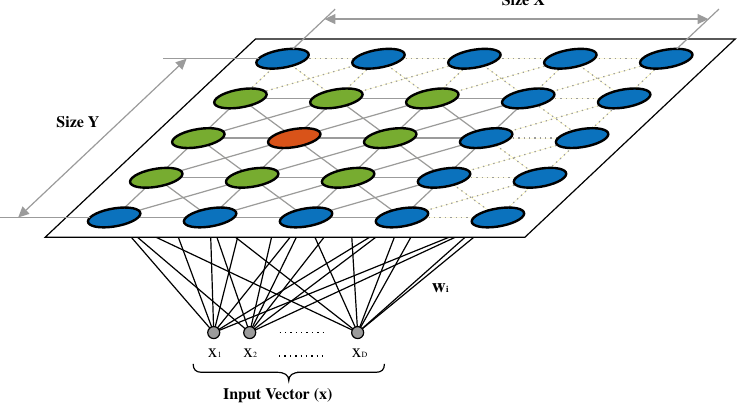
Figure 6. Self-organizing-map